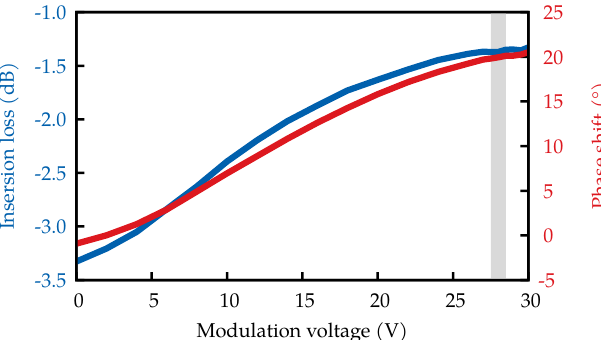
Figure 3. Layout of the phase modulator and phase shifter realized on 0.76 mm-thick Rogers RO4350B laminate. The varactors are Infineon BB857-02V with 10 k Ω bias resistors. For the phase modulation, a small phase change in the range of 1° or less is required, meaning that a single resonant element suffices. Figure 4 shows the response of the used modulator.